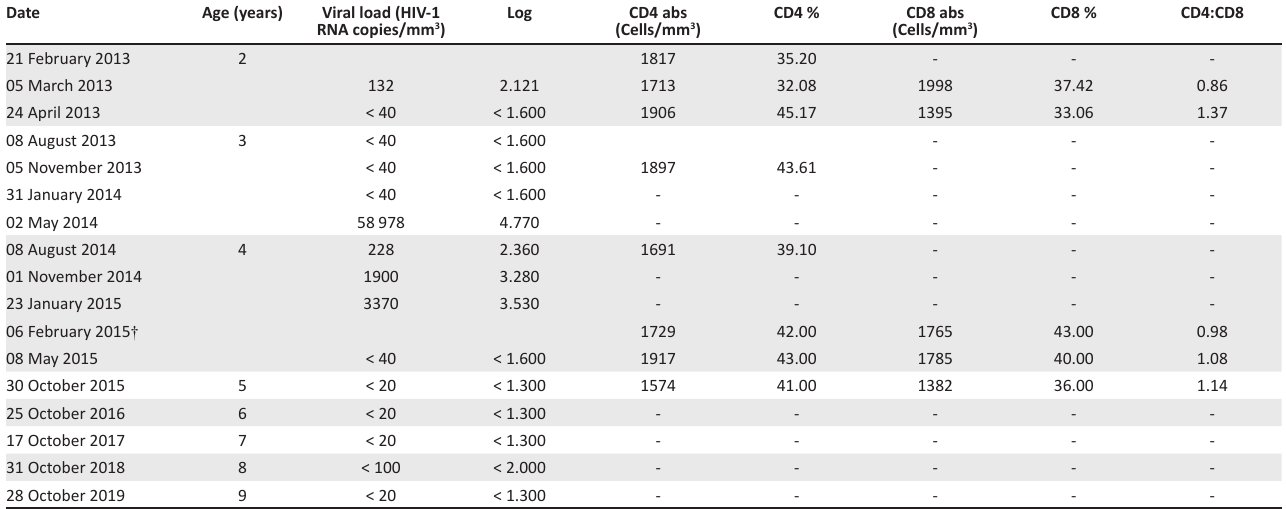
TABLE 2a: Laboratory data for patient 1.